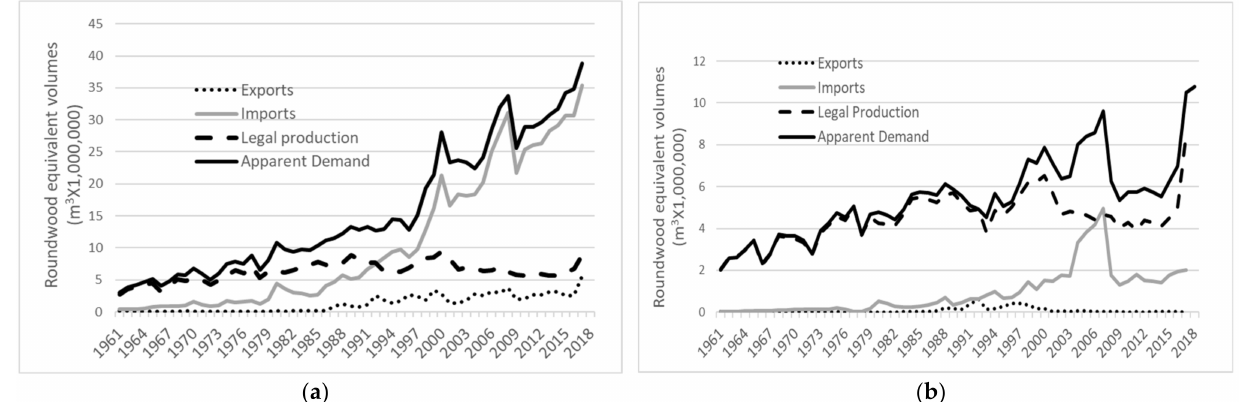
Figure 1. Production, imports, exports, and apparent demand of ( a ) all wooded products and ( b ) sawn wood products. Source: Data from FAOSTAT [27] and SEMARNAT